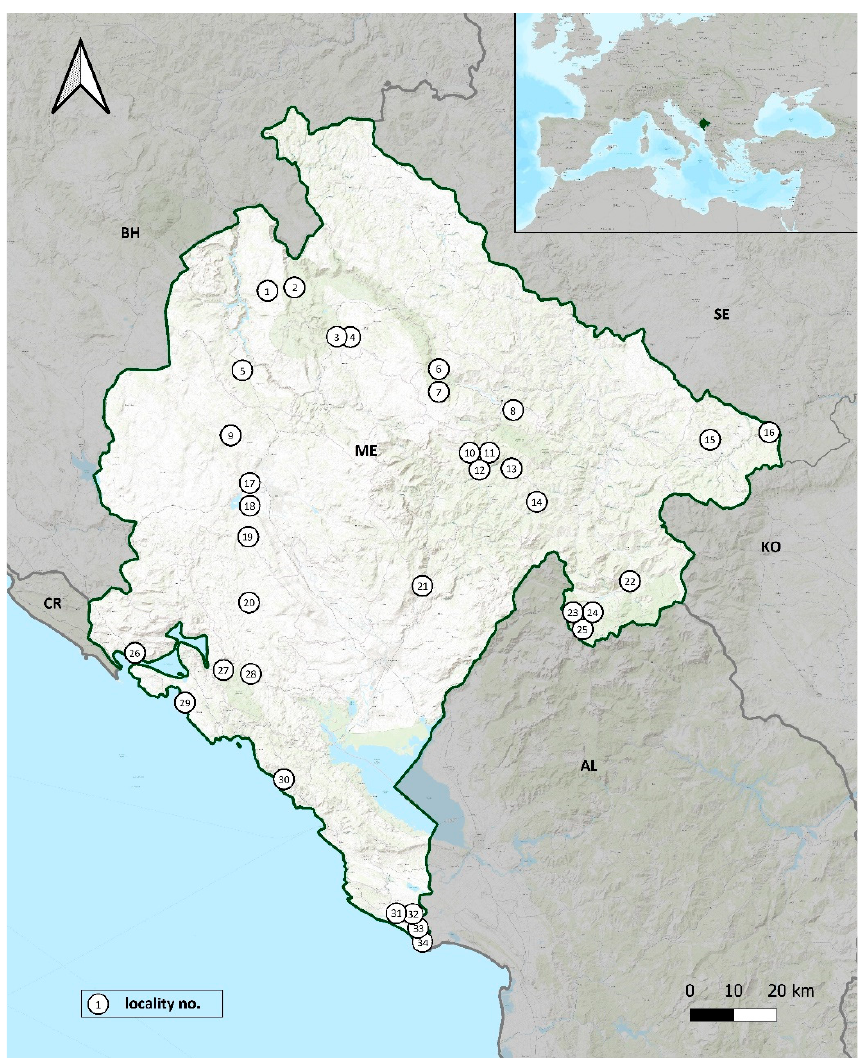
Figure 1. Collection localities of the scarabaeoid beetles in Montenegro (2019, 2021) (numbers of the localities correspond to those in Table 1).